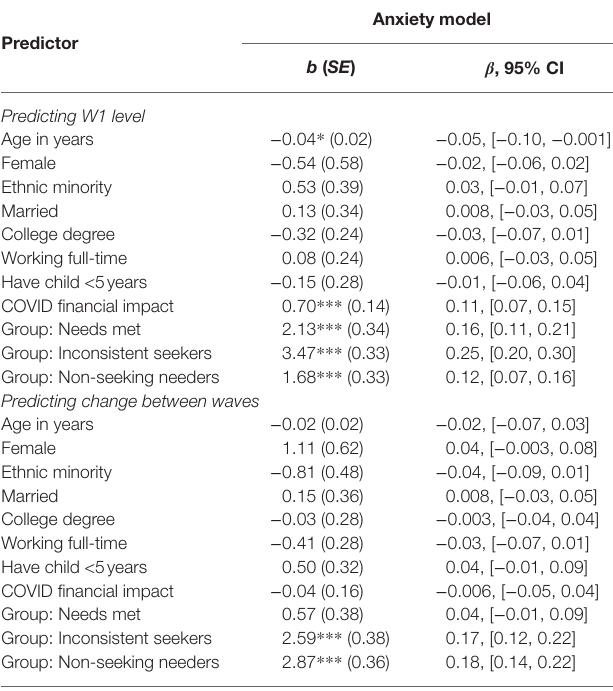
b (SE), unstandardized coefficient (standard error); β , 95% CI, standardized coefficient, 95% confidence interval. Effects of the three groups compare them to the reference “no need”